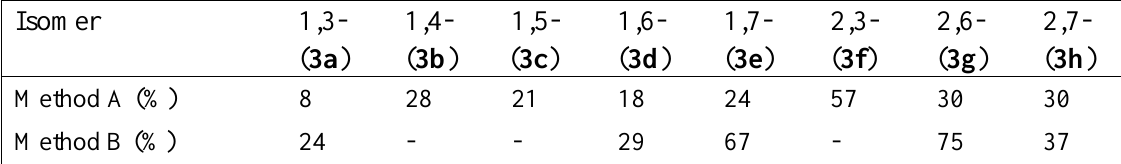
Table 1. Isolated yields for the various isomers of 3